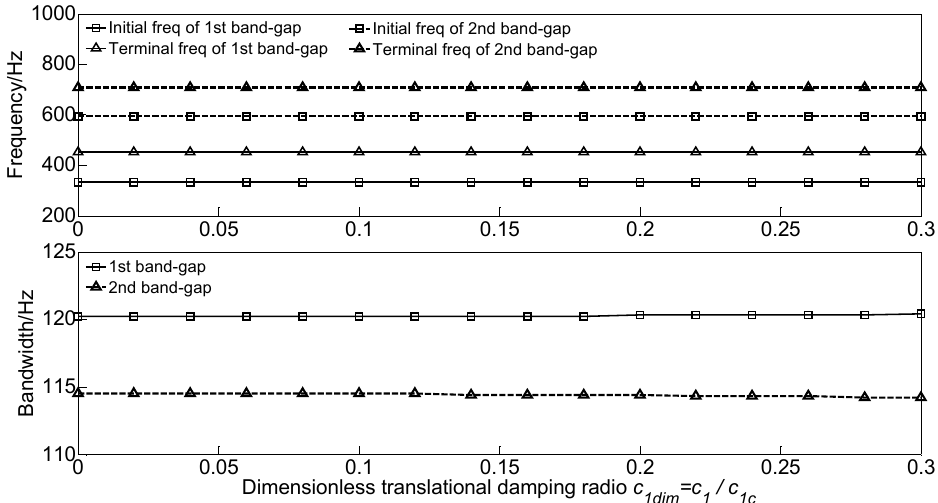
Figure 9. Band gaps maps as functions of dimensionless translational damping radio c 1dim.